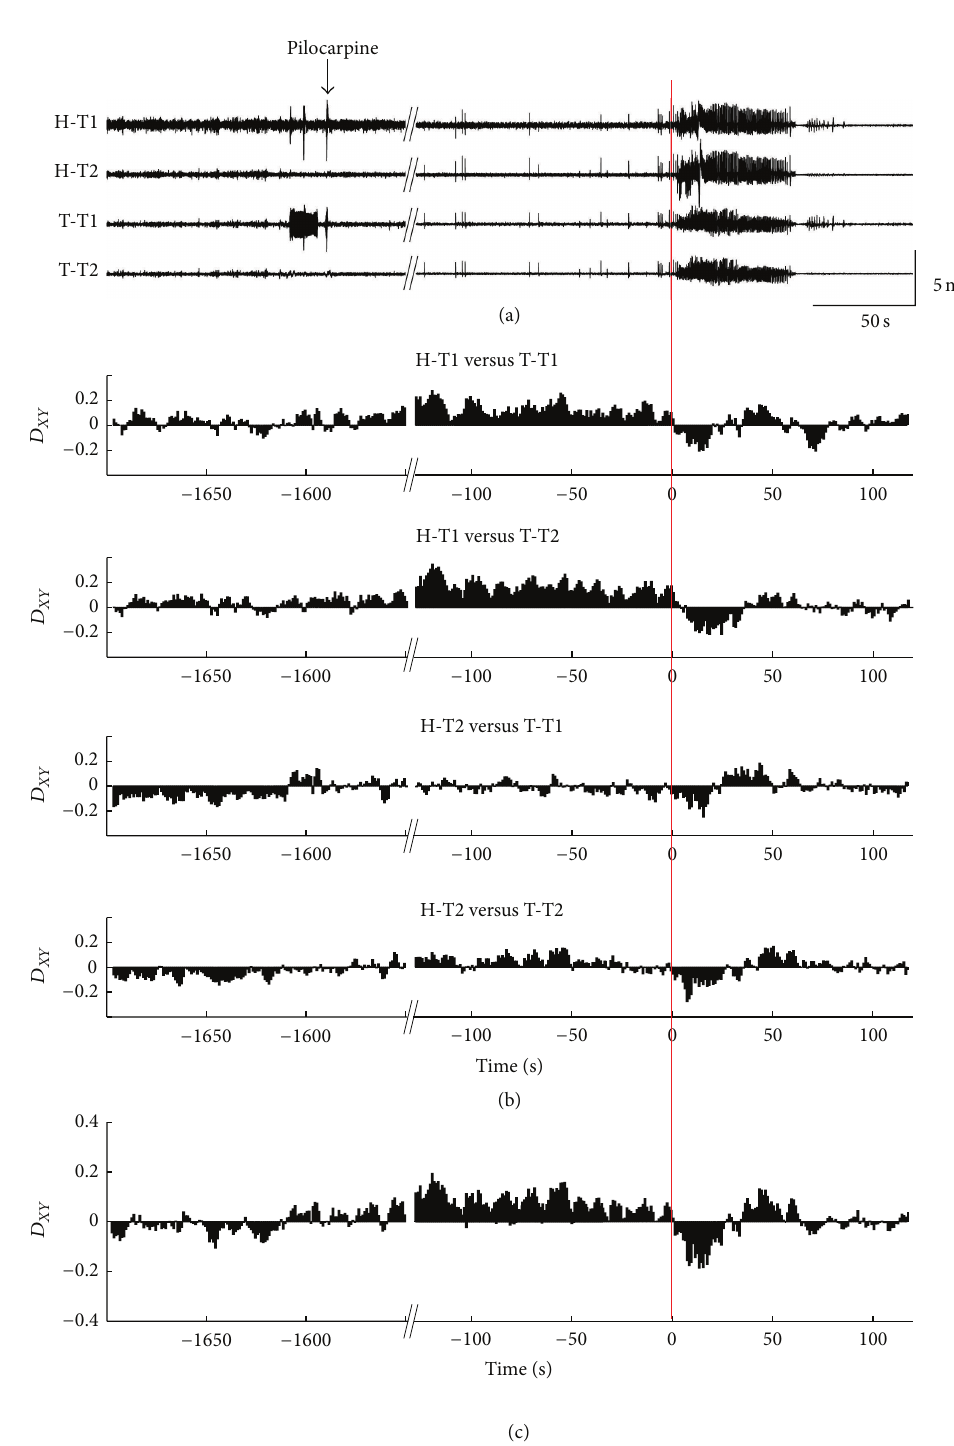
Figure 5: One example of peri-ictal coupling dynamics between hippocampus and thalamus. (a) Mean values of LFPs recorded from four channels of each tetrode. (b) The directionality index ( 𝐷 𝑋𝑌 ) between hippocampus and thalamus. We calculated 𝐷 𝑋𝑌 between each tetrode’s recording from hippocampus and thalamus of the example mouse, getting four combinations. (c) The averaged directionality index ( 𝐷 𝑋𝑌 ). The red line indicates the seizure onset time. H, hippocampus; T, thalamus; T1&T2, Tetrode 1 and Tetrode 2 in a